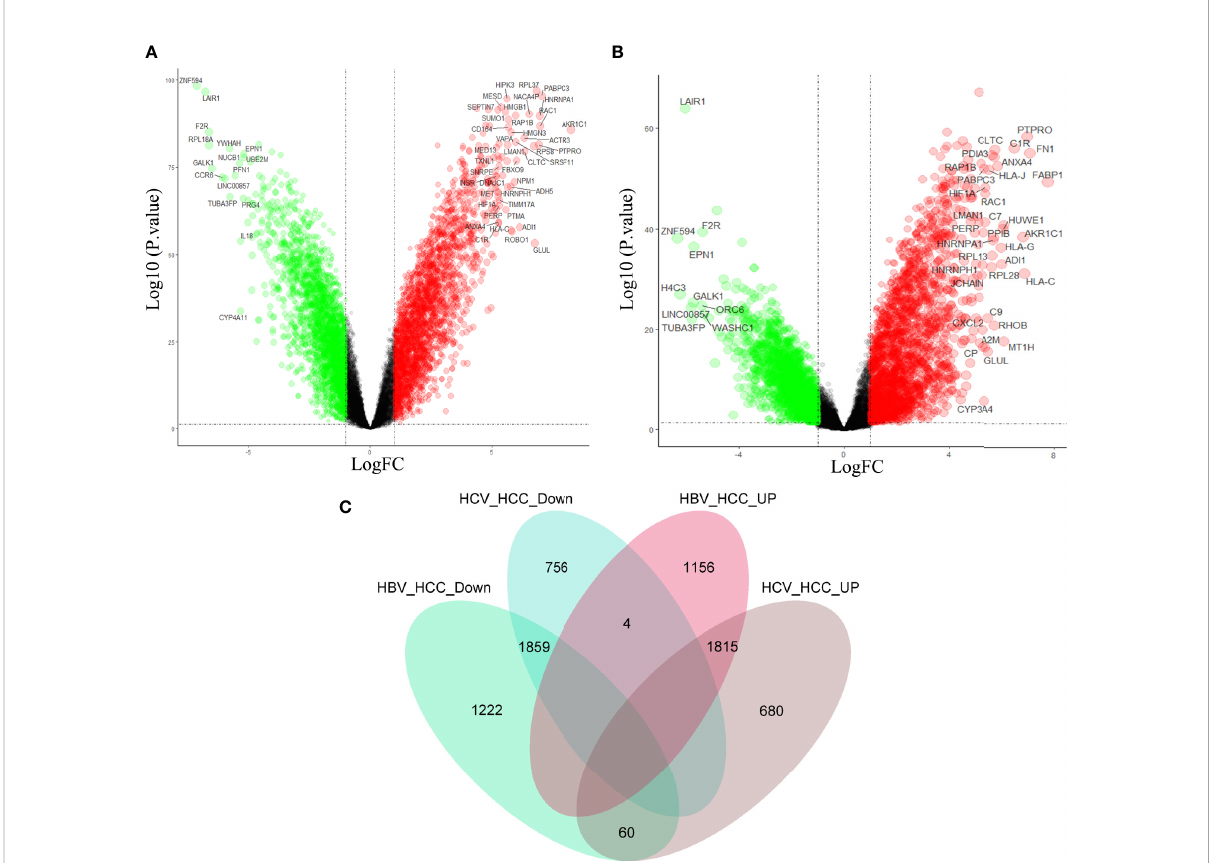
FIGURE 3 Differential gene analysis and intersection gene Venn diagram. Gene expression pro fi les of HBV-HCC (A) and HCV-HCC (B) compared with HCC. (C) Drawing the intersecting Venn diagram to clarify the molecular mechanism of HCC co-caused by hepatitis viruses.